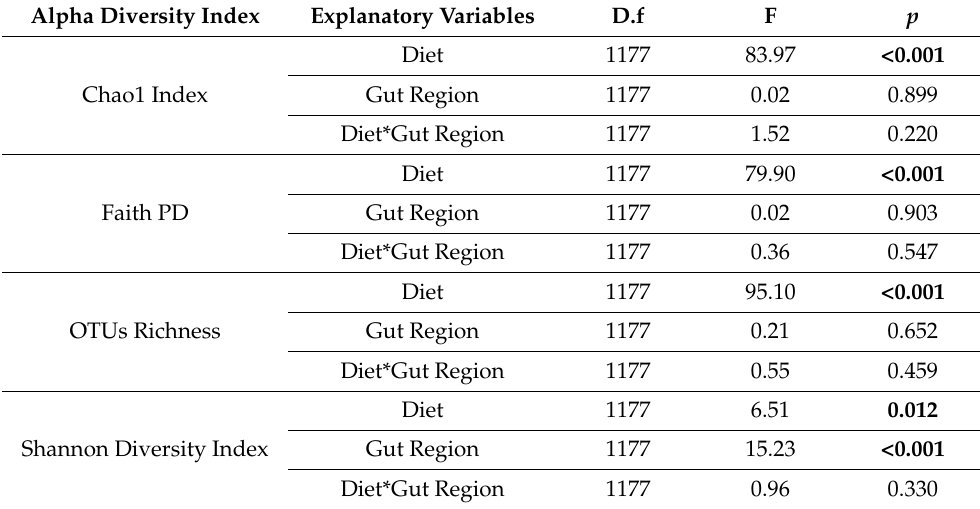
Table 2. General linear mixed models exploring the effects of fish experimental diet (control and supplemented with Allium -derived PTSO) and gut region in different alpha diversity indices of bacterial community of juvenile European seabass. D.f. refers to degree of freedom. Significant p -values are shown in bold.